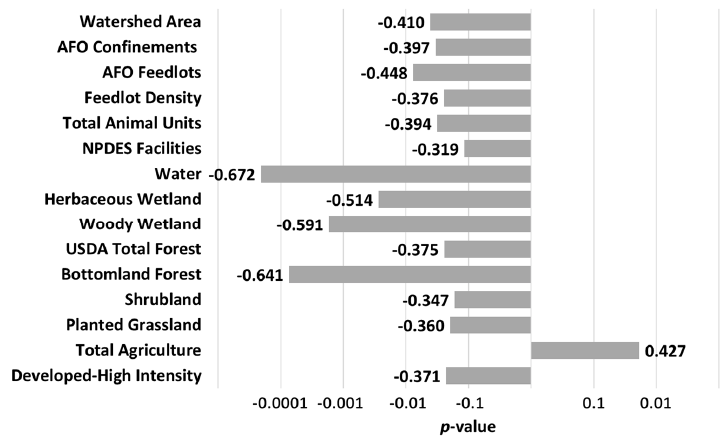
Figure 3. The p -value and Spearman’s rank correlation coefficients (data labels) by watershed characteristic ( n = 30); positive and negative directions of ordinates depict positive and negative correlations between E. coli and the corresponding watershed characteristics.